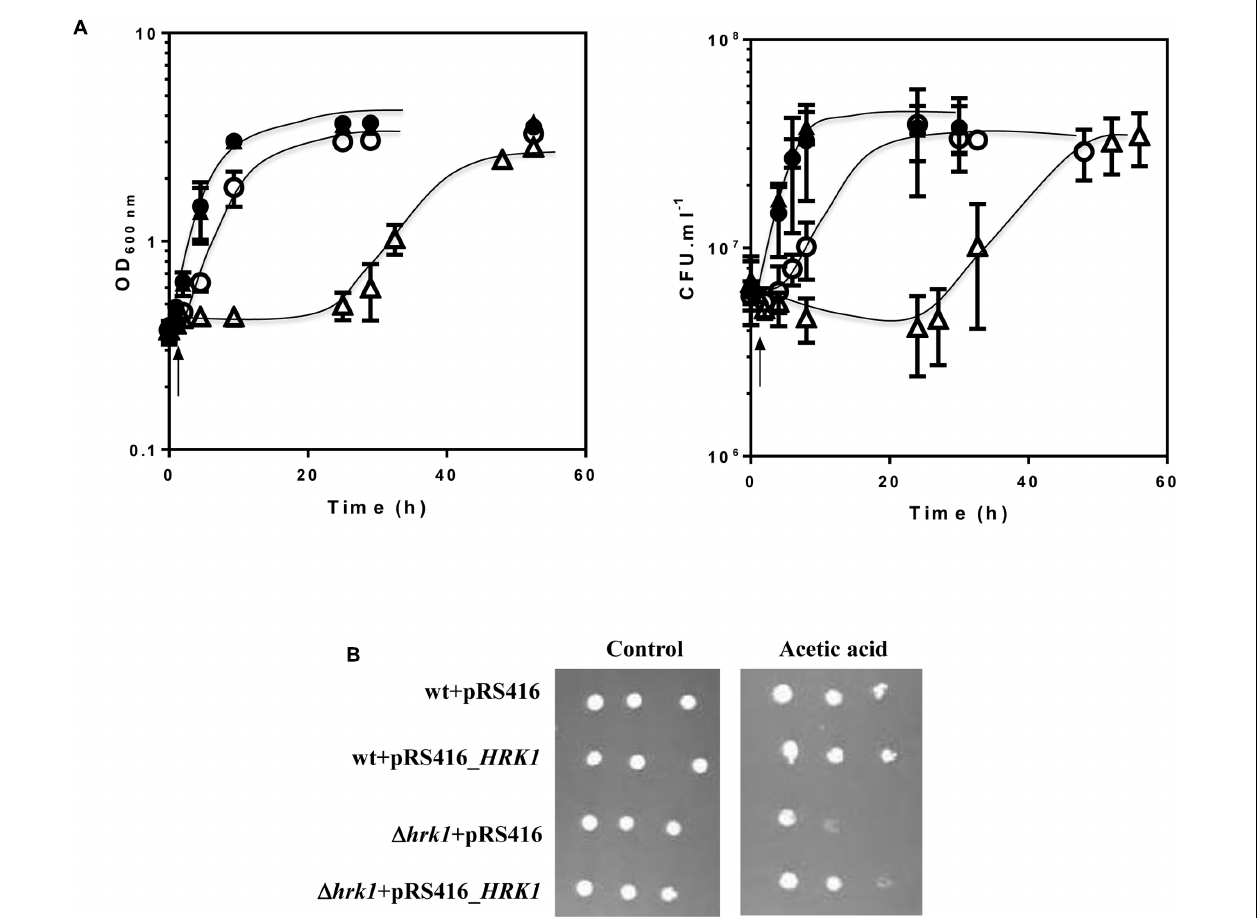
FIGURE 1 | Comparison of the susceptibility of Saccharomyces cerevisiae BY4741 and of the derived deletion mutant hrk1 (cid:49) to acetic acid stress. (A) Growth curves of S. cerevisiae BY4741 ( , ) and hrk1 (cid:49) ( (cid:7) , ♦ ) cells in MM4 medium (at pH 4) (closed symbols) or in this same growth medium supplemented with 50 mM acetic acid (open symbols). The concentration of viable cells was assessed as the number of CFU per milliliter of cell culture (CFU.ml − 1 ). The arrow indicates the (cid:32) (cid:35) time-point at which samples were collected for phosphoproteomic and lipidomic analyses. (B) The acetic acid-susceptibility phenotype of the hrk1 (cid:49) mutant is rescued upon complementation with a plasmid driving ectopic expression of the HRK1 gene. BY4741 and BY4741_ hrk1 (cid:49) cells transformed with the pYGC_ HRK1 plasmid were cultivated in liquid MM4 growth medium (at pH 4), harvested in mid-exponential phase (OD 600 nm = 0.8 ± 0.5) and finally diluted, in water, to obtain a cell suspension with an OD 600 nm of 0.05. Four µ l of this cell suspension and of two subsequent dilutions (1:5 and 1:25) were spotted onto the surface of